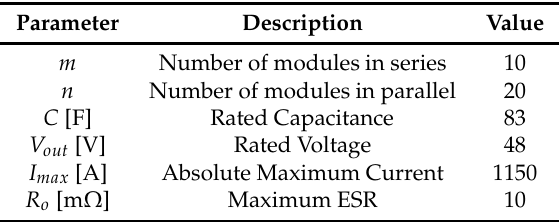
Table 2. Supercapacitor parameters.